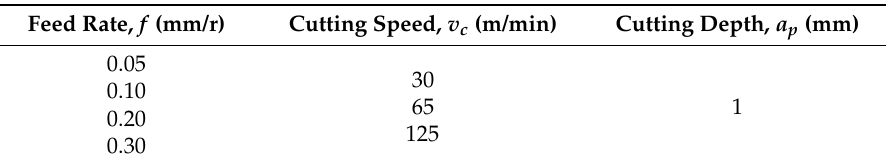
Table 2. Cutting parameters.